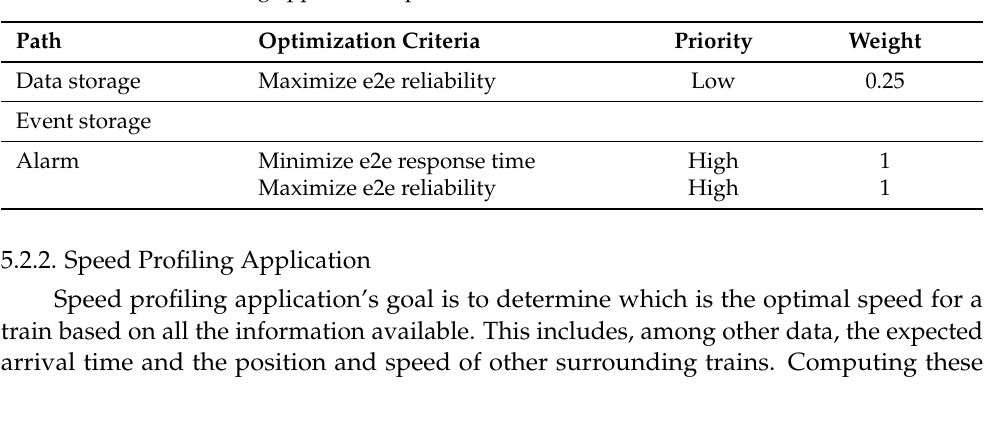
Table 5. Smoke monitoring application optimization